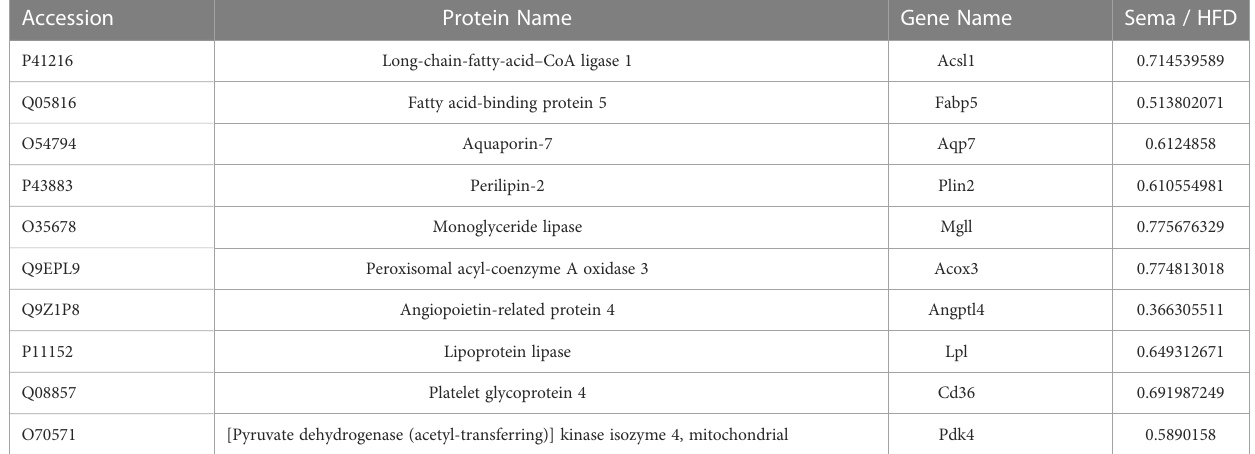
TABLE 5 DEPs down -regulated in the Sema/HFD group modulating the lipid